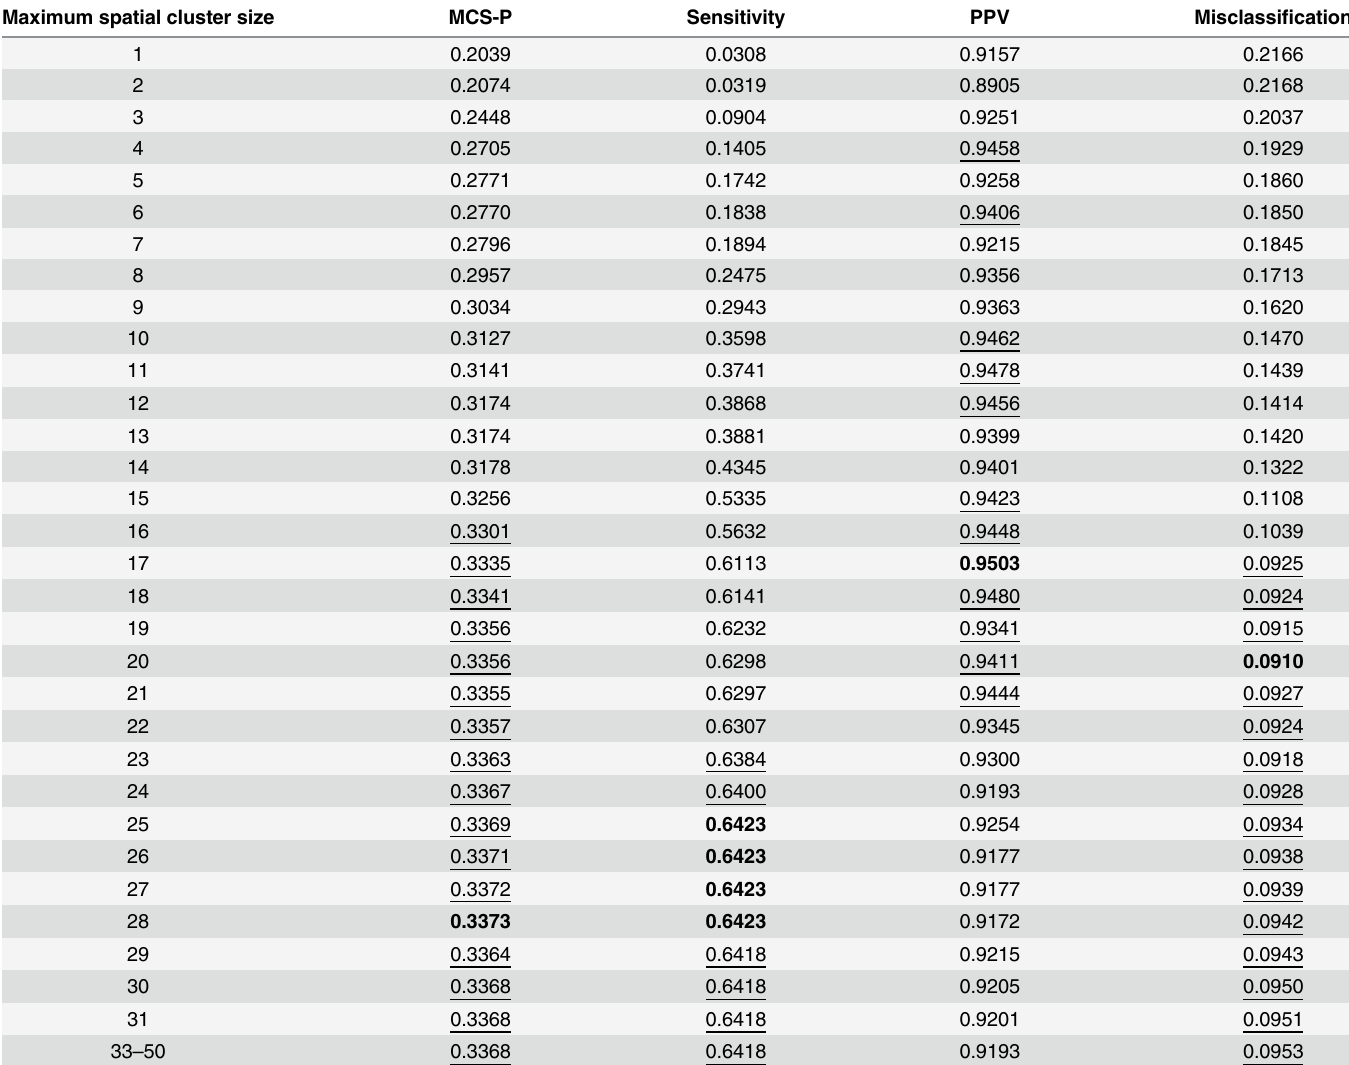
Table 3. Average performance measures for different maximum spatial cluster sizes in